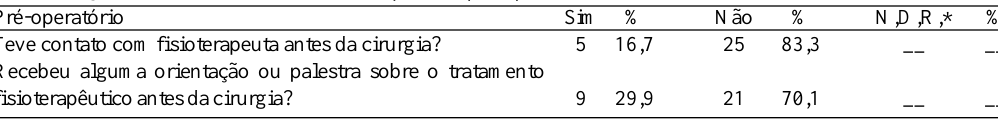
Tabela 2. Questionamentos relacionados ao período pré-operatório.